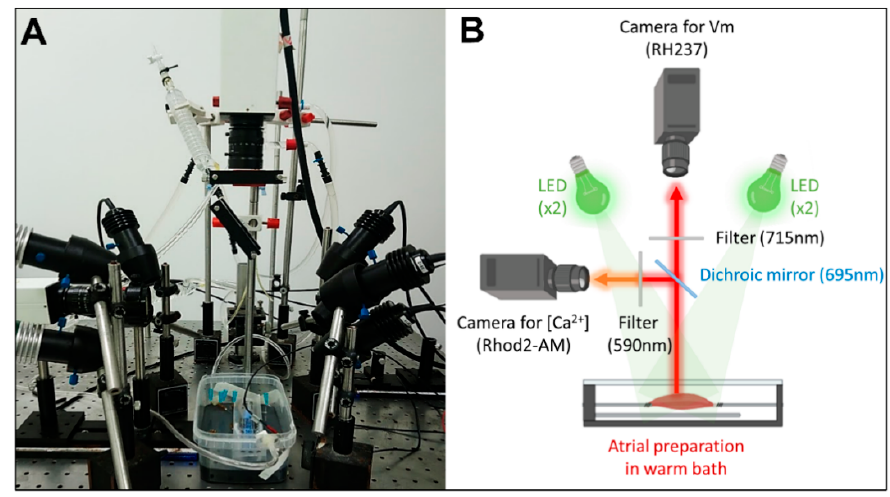
Figure 1. Experimental set-up for dual optical mapping of V m and [Ca 2+ ] i . ( A ) Picture and ( B ) sche- matic diagram of the optical design.